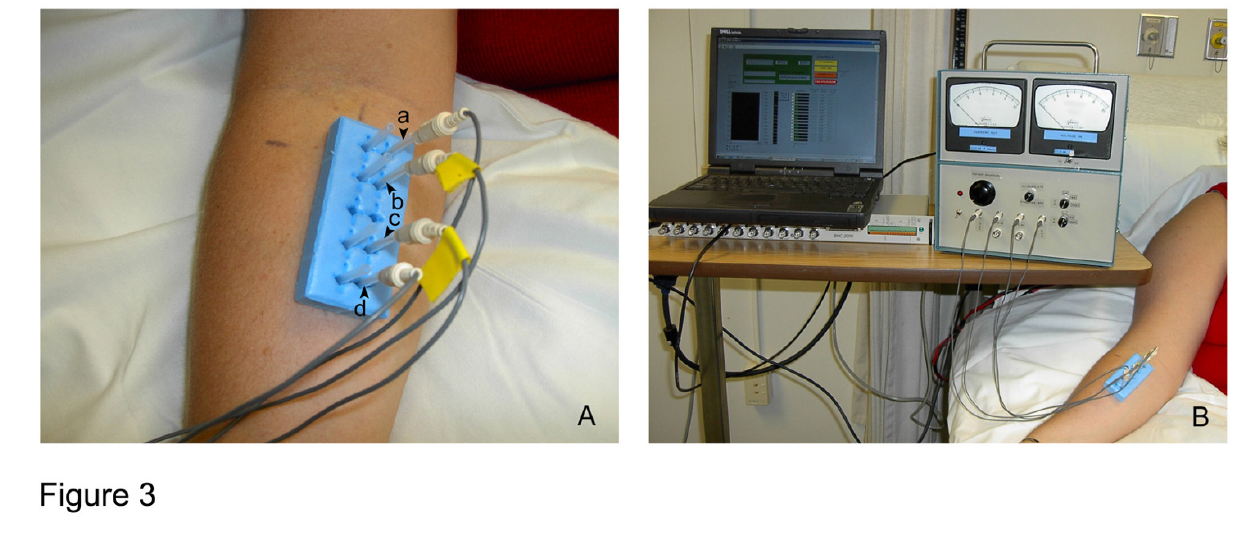
Experimental setup Figure